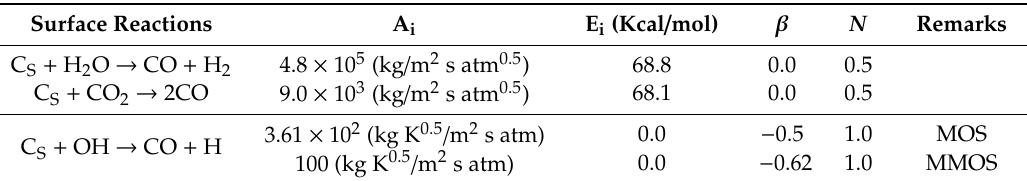
Table 1. Kinetic data for heterogeneous